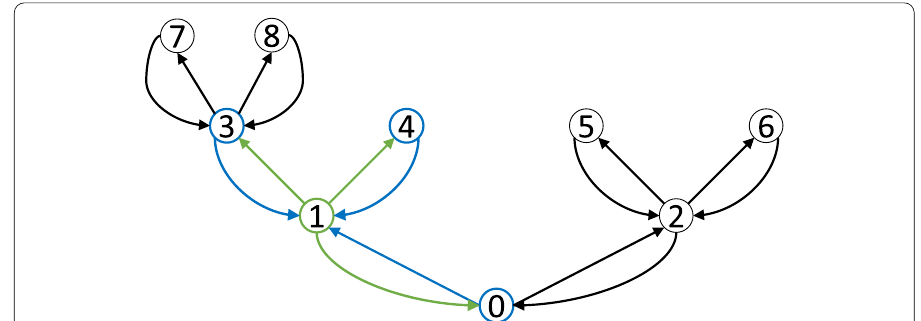
Fig. 4 Communication tree with selected neighbours of node-#1 for fail-safe mechanism. Green arrows represent the node-#1 alive messages sent to its neighbour nodes. Blue arrows represent the node-#1 alive messages received from the neighbour